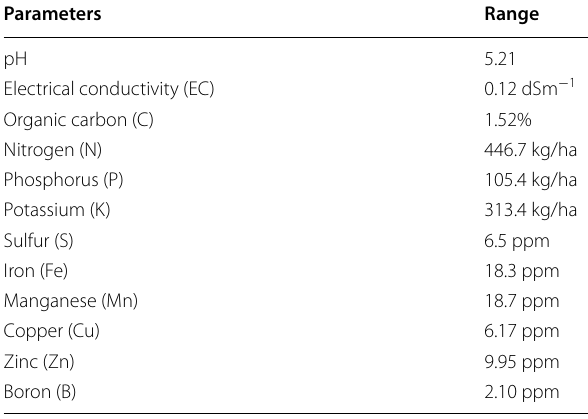
Table 1 Soil analysis Parameters Range